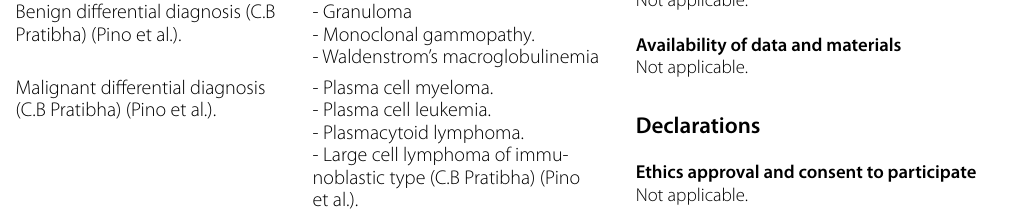
Table 2 Differential diagnosis of extramedullary